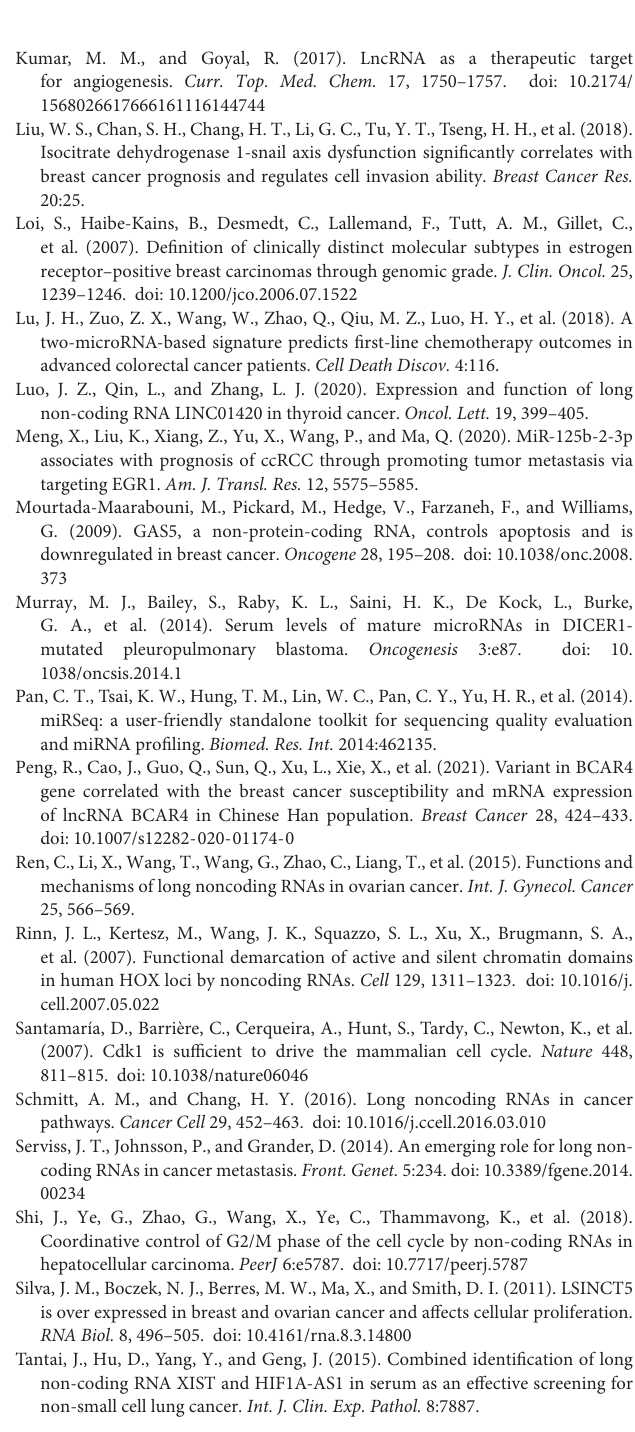
assessed in breast cancer tissue samples ( n = 778) compared with adjacent normal tissue samples ( n = 87; TCGA database). Supplementary Figure 6 | (A) Impacts of miR-125b-2-3p expression on the OS of patients with breast cancer. (B) Combination of LOC550643 and miR-125b-2-3p expression levels was correlated with the survival curve of patients with breast